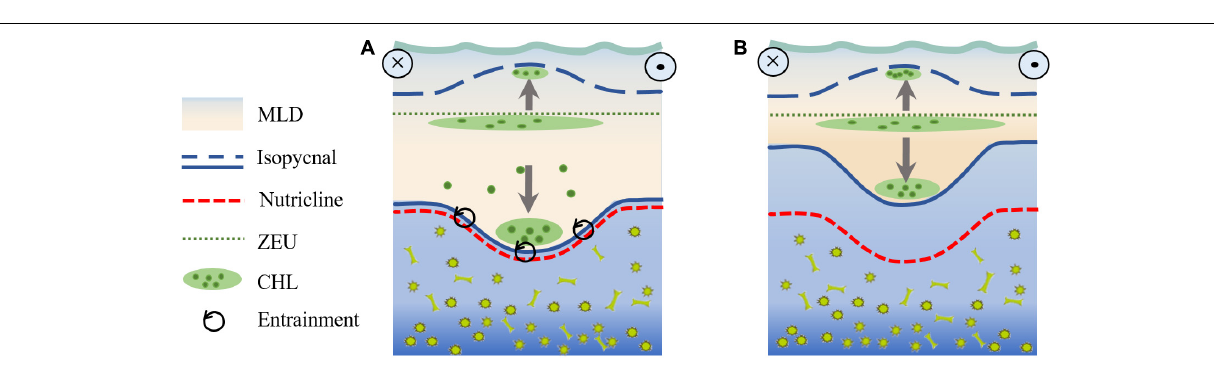
FIGURE 14 | A schematic diagram of SSAE intensification-induced pumping and winter mixing for the (A) NLM and (B) LM paths in the region off the southern coast of